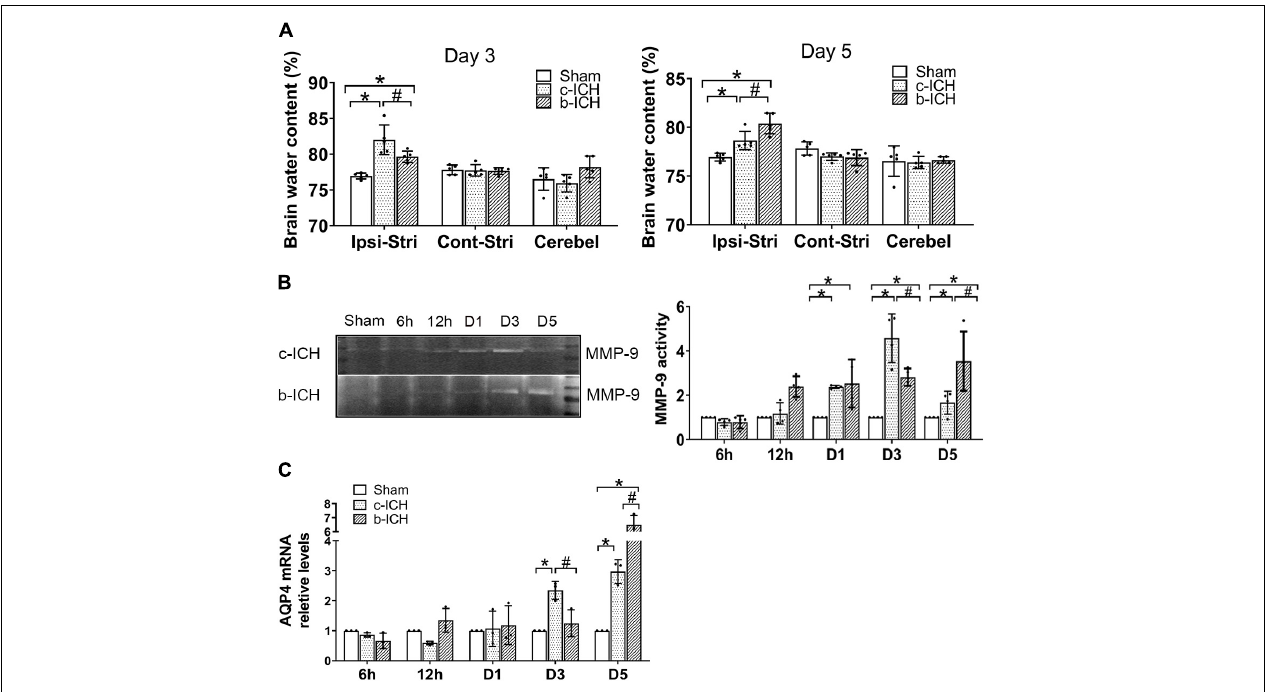
FIGURE 5 | The comparison of the expressions of aquaporin 4 (AQP4) and MMP-9 activity in brain tissue between c-ICH and b-ICH groups. (A) Measurement of brain water content on days 3 and 5 ( n = 6 mice/group; * P < 0.05 vs. sham group, # P < 0.05 vs. the c-ICH group repeated measures ANOVA followed by Bonferroni post-hoc test). Cont-Stri, contralateral striatum; Ipsi-Stri, ipsilateral striatum. Values are mean ± SD. (B) Gelatin zymography shows MMP-9 activity in brain tissue at 6 h, 12 h, day 1, day 3, and day 5 after ICH in both models. Quantification of MMP-9 activity in the brain ( n = 4 mice/group, * P < 0.05 vs. sham group, # P < 0.05 vs. the c-ICH group; the repeated measures ANOVA followed by the Bonferroni post-hoc test). (C) Quantification of AQP4 mRNA levels in the brain at 6 h, 12 h, day 1, day 3, and day 5 after ICH in the c-ICH and the b-ICH groups ( n = 3 mice/group, four fields quantified per mouse; * P < 0.05 vs. sham group, # P < 0.05 vs. the c-ICH group; the repeated measures ANOVA followed by the Bonferroni post-hoc test). Values are mean ±